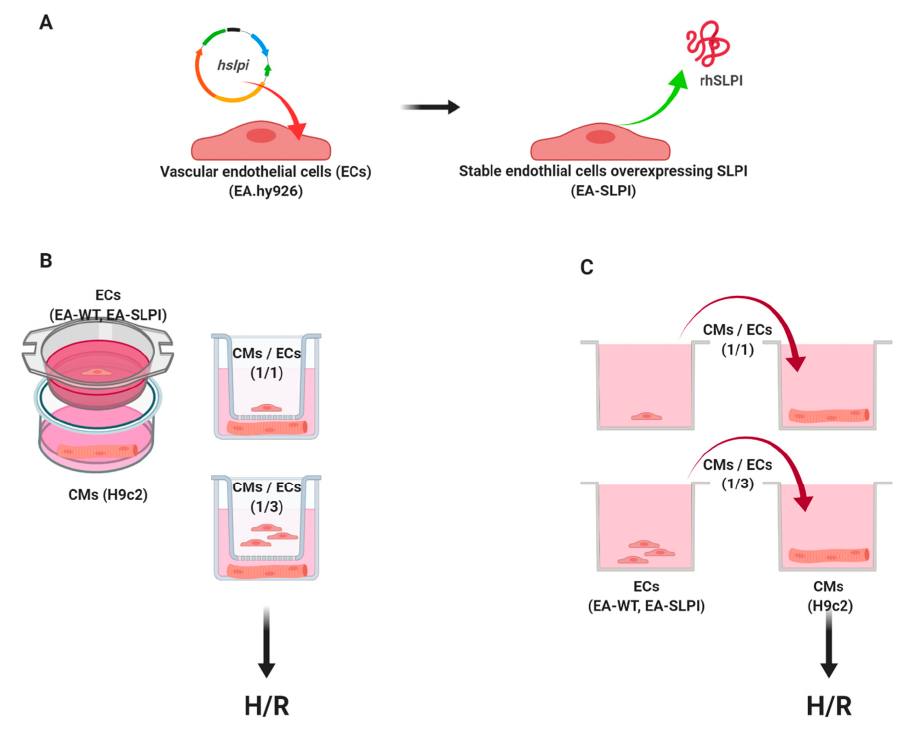
Figure 1. Schematic diagram of the experimental design. Vascular endothelial cells (EC) (EA.hy926) were stably transfected by a eukaryotic expression vector containing human secretory leukocyte protease inhibitor (SLPI) mRNA ( hspli ) ( A ). The stable cells overexpressing recombinant human SLPI were used for further experiments. Determination of the paracrine e ff ect of endothelial-derived SLPI on cardiomyocyte (CM) (H9c2) subjected to hypoxia / reoxygenation (H / R) injury was performed via techniques following two di ff erent principles: co-culture between SLPI-overexpressing EA.hy926 cells and H9c2 cells by the Transwell culture system ( B ), and conditioned medium from SLPI-overexpressing EA.hy926 cells ( C